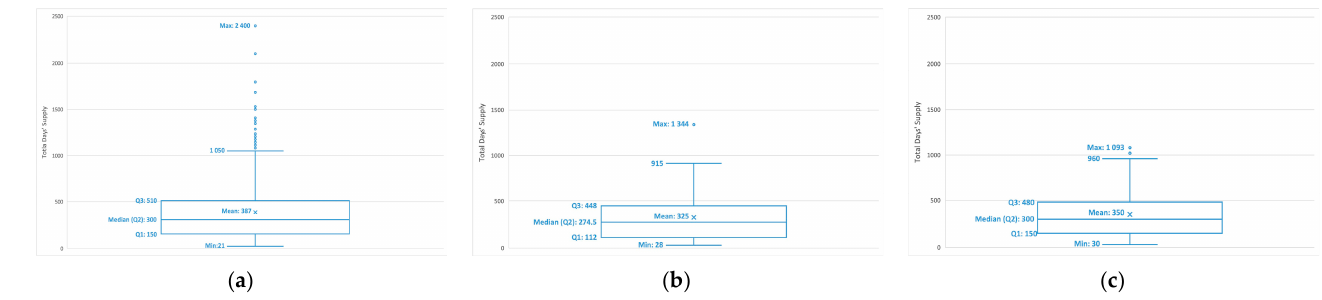
Abbreviations: NR: not reported. 1 Age measured at the start of the EGFR ‐ TKI of interest. 2 Quebec lung cancer cohort developed by INESSS, in which age was measured at the diagnosis date [3]. 3 Range: minimum; maximum.